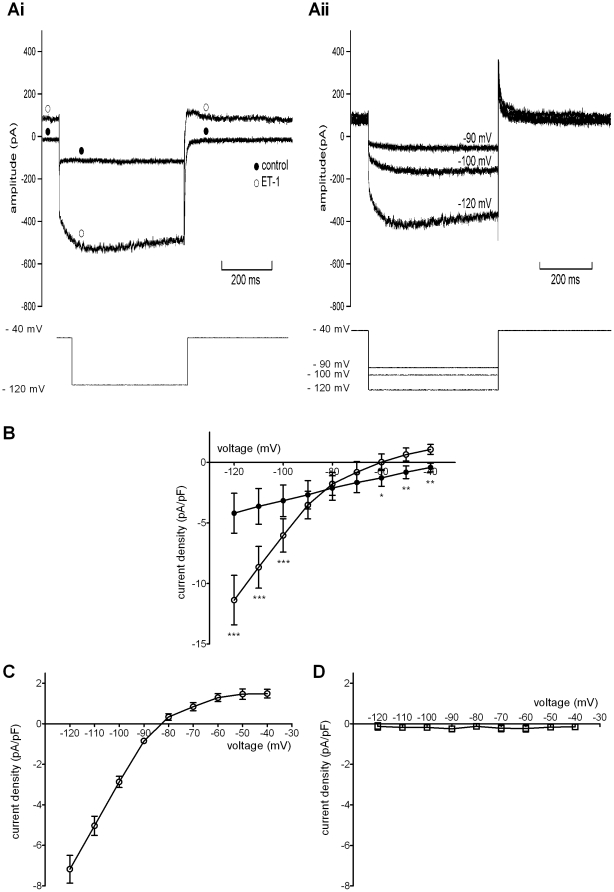
Modulation by ET-1 of instantaneous current in cells lacking If.Ai. Currents recorded in the absence (control) and the presence of 10 nM ET at −120 mV (upper traces) when a voltage command was applied from −40 mV for 500 ms (lower trace). Note outward shift in holding current with ET-1. Closed circles indicate control trace; open circles indicate trace in ET-1. Aii. ET-1 activated currents (elicited at −90, −100 and −120 mV) obtained by digital subtraction of control from ET-1 records (same cell as Ai). B. Mean current-voltage (I–V) relationships for current measured at the start of applied voltage commands in absence (control, filled circles) and presence (open circles) of 10 nM ET-1 (n = 7). Asterisks denote statistical significance (p<0.05 *, p<0.01 **, p<0.001 ***). C. Plot of the mean I–V relationship for ET-1 sensitive difference (ET-1 activated) calculated from the same cells shown in B. D. Plot of ET-1 sensitive current when ET-1 was applied after 1 µM BQ-123 (n = 4).